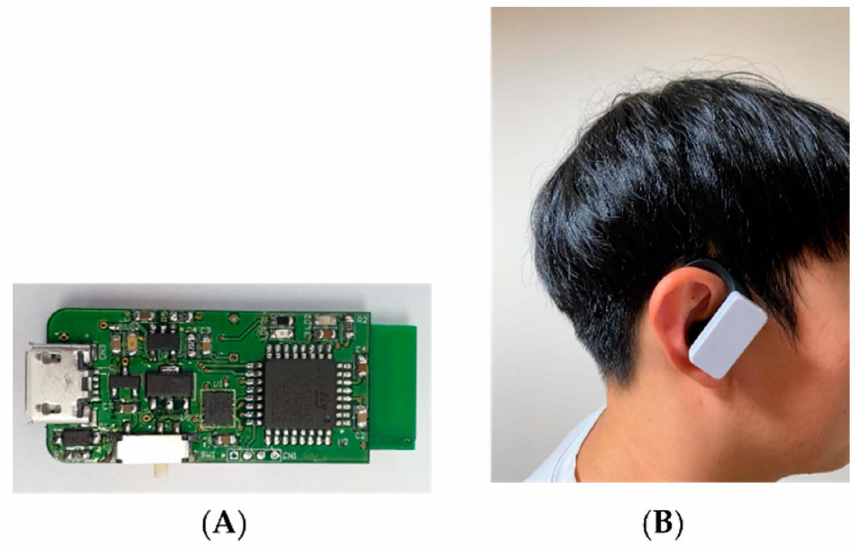
Figure 1. Earbud-type IMU sensor. ( A ) IMU sensor. ( B ) IMU sensor attached to the